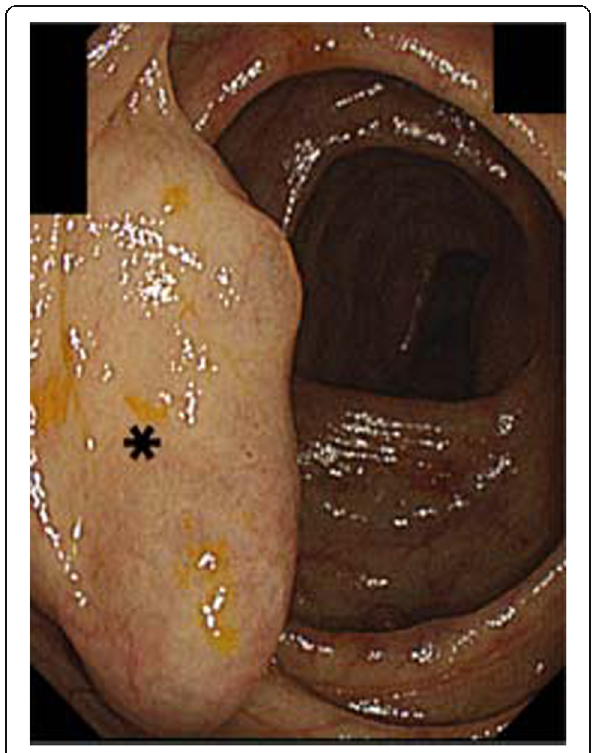
Fig. 1 Endoscopic examination performed before B-RTO using CARTO-II. The endoscopy shows a varix (asterisk) located at the ascending